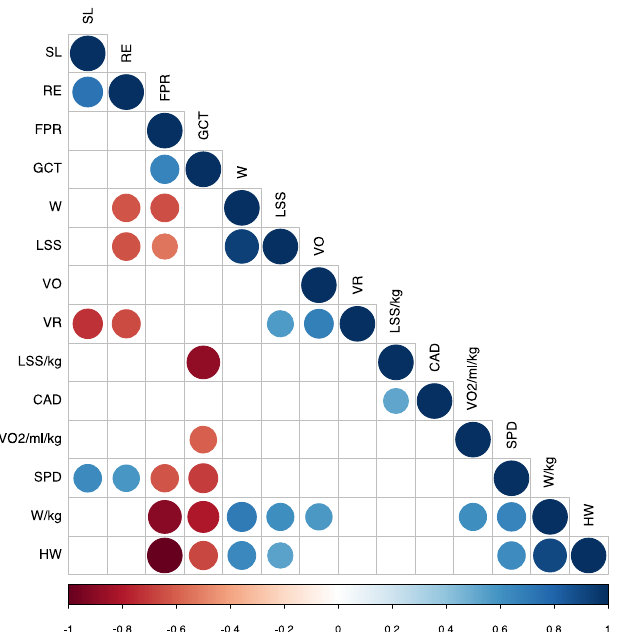
Figure 3. Correlations map representing only the significant ( p < 0.05) variables. Power (W), leg spring stiffness (LSS), vertical oscillation (VO), power per kilogram (W/kg), speed (SPD), cadence (CAD), ground contact time (GCT), and the (CAD), ground contact time (GCT), and the form power ratio form power ratio (FPR).